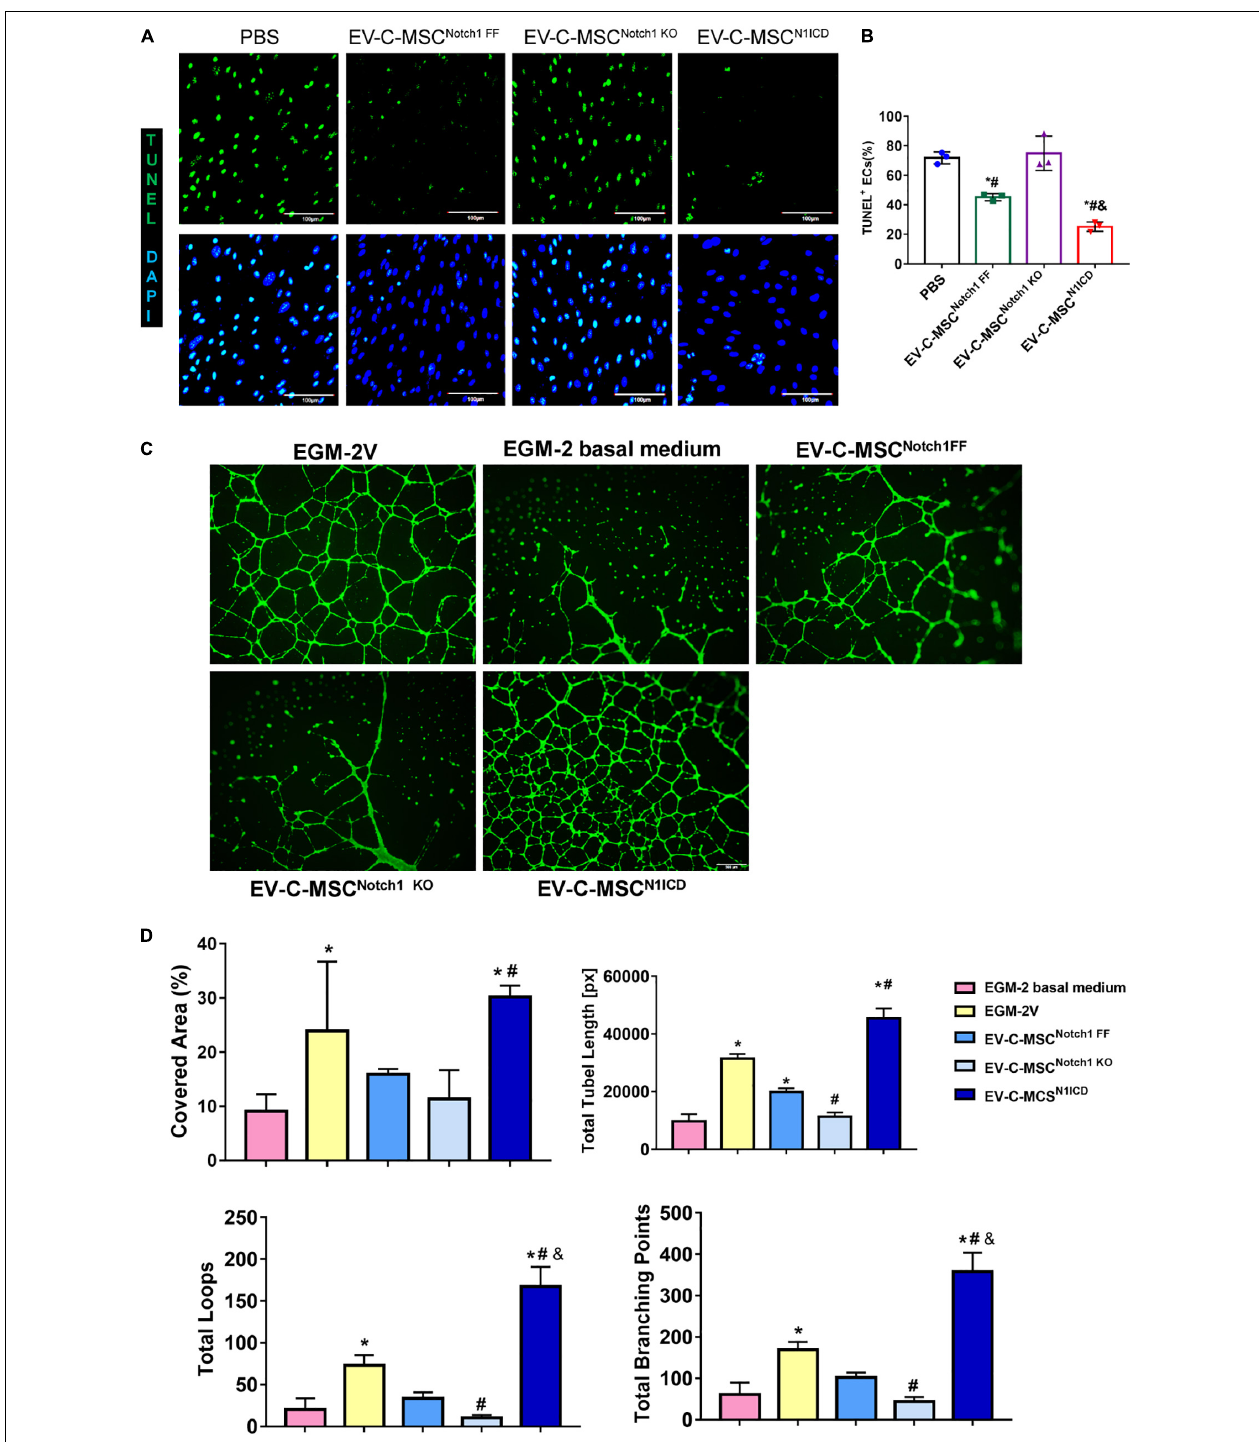
FIGURE 4 | In vitro cardioprotective effects of EV-C-MSCs N1ICD . (A) Representative images of TUNEL staining in mouse ECs which were pretreated with EVs from C-MSCs Notch1FF , C-MSCs Notch1KO , and C-MSCs N1ICD (1 µ g/well, 12-well plate) for 24 h and then were subjected to 8 h H 2 O 2 (300 µ M) treatment. Bar = 100 µ m. (B) Quantitative analysis for TUNEL staining in mouse ECs. * vs. PBS group, # vs. EV-C-MSC Notch1KO group, & vs. EV-C-MSC Notch1FF group, P < 0.05. (C) Representative images of tube formation in human aortic endothelial cells (HAECs) with EV treatment from C-MSCs Notch1FF , C-MSCs Notch1KO , and C-MSCs N1ICD (1 µ g/well, 24-well plate). EGM-2V medium and EGM-2V basal medium (without VEGF) served as controls. HAECs were labeled with Calcein AM (Green). Bar = 500 µ m. (D) Quantitative evaluation for tube formation assay. Covered area, total tube length, total branching points, and total loops were analyzed from three biological repeated experiments. Bar indicates 500 µ m. * vs. EGM-2 basal medium group, # vs. EV-C-MSC Notch1FF group, & vs. EGM-2V group, P < 0. 05.